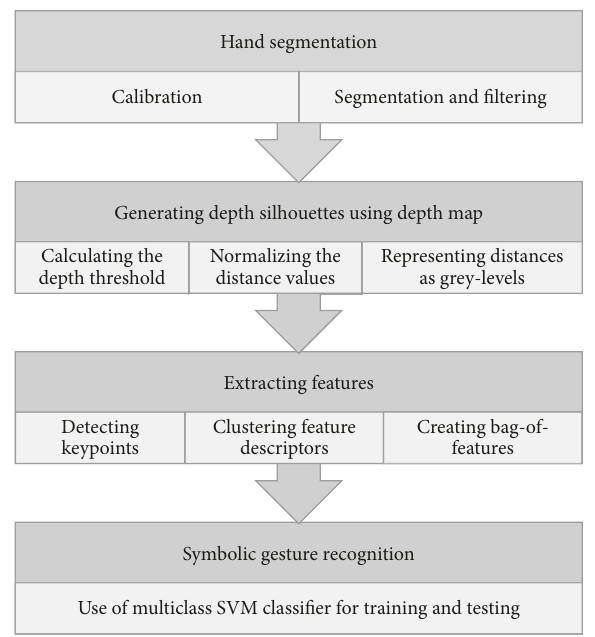
Figure 2: The architecture to recognize symbolic gestures.